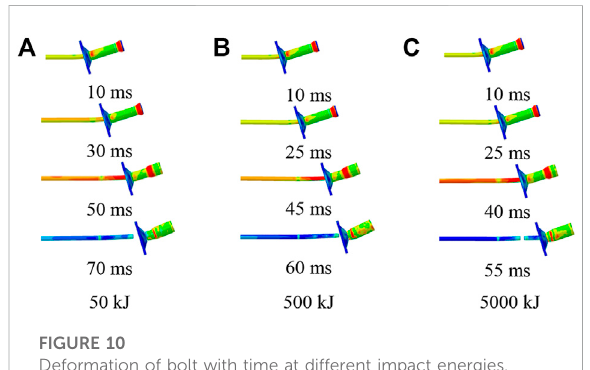
FIGURE 11 Anchor force-time curve.